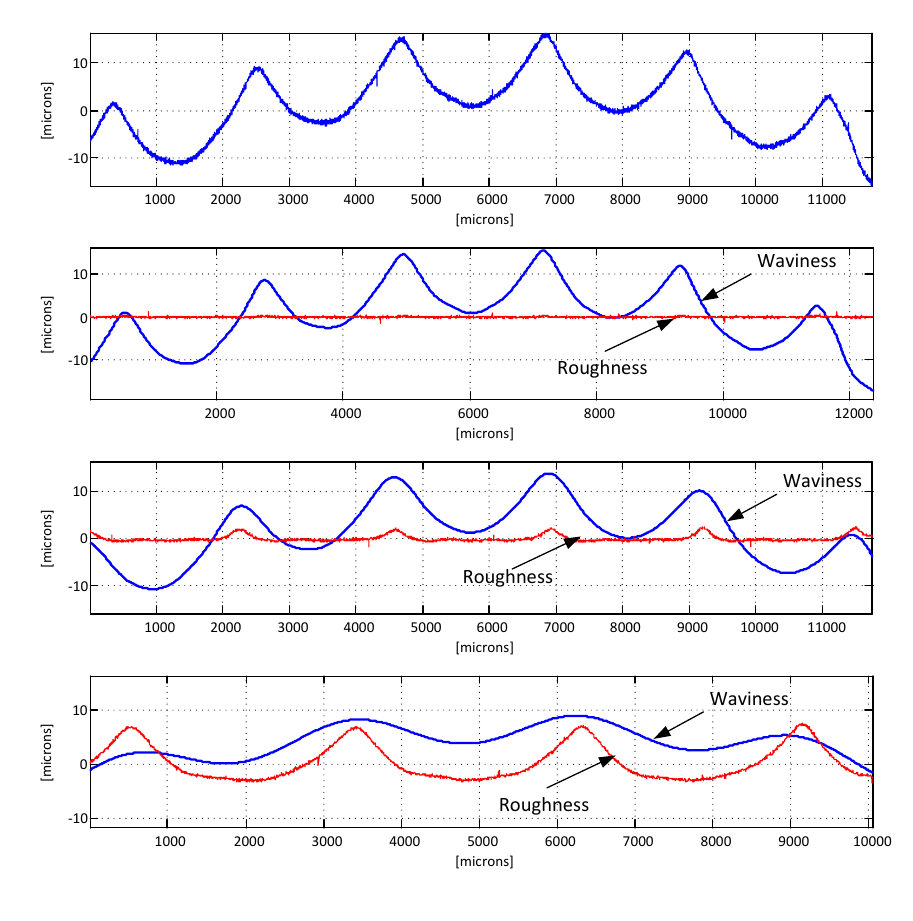
Figure 4. Separation of the waviness and roughness profiles from a sample. From top to bottom: a profile of a Rubert Type 130 reference specimen of a surface machined by horizontal milling (in this case the N8) obtained with a contact stylus instrument, and the = 0.25, 0.8 and 2.5 waviness and roughness profiles obtained with values of λ c